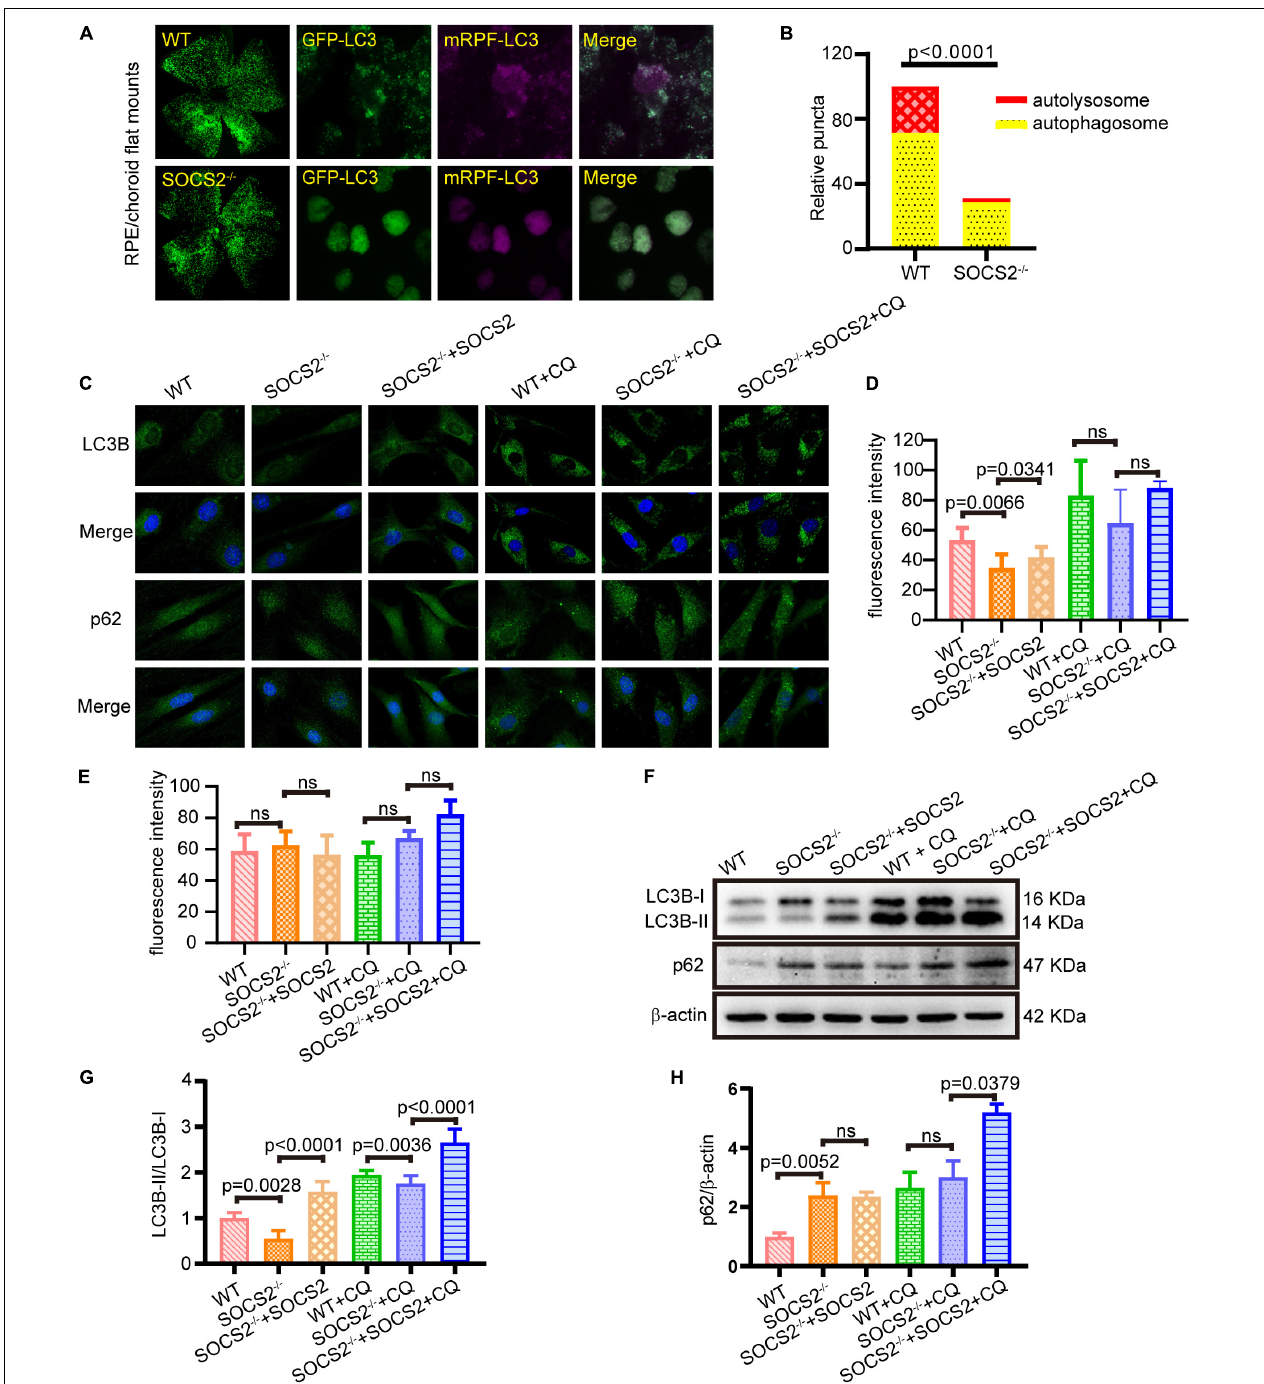
FIGURE 2 | RPE lacking the SOCS2 gene exhibited impaired autophagy. (A) In vivo , autophagic flux was detected by injecting 2 µ l of 1 × 10 12 vg/ml adeno-associated virus 2 (AAV2)-mRFP-GFP-LC3 in the eyeball of adult WT and SOCS2 − / − mice subretinally. About 2-weeks later, mice were starved for 24 h before euthanasia, and RPE/choroid flat mounts were isolated from mice ( n = 8, 10-week old, including males and females). (B) The numbers of autophagosomes and autolysosomes were evaluated by counting yellow and RFP dots. Puncta dots per horizon are shown as the mean ± SEM. (C) LC3B puncta dots (green) and p62 puncta dots (green) were stained by immunofluorescence in mouse primary RPE cells that were starved and treated with or without 30 µ M CQ for 24 h. One group of SOCS2 − / − RPE re-expressed SOCS2 by transient transfection. (D,E) Fluorescence intensity of LC3B and p62 were quantified by the ImageJ software. (F) Immunoblotting for LC3B and p62 was performed in mouse primary RPE with different treatments. (G) The ratio of LC3B-II/LC3B-I was quantified by ImageJ software and normalized to β -actin. (H) p62 was quantified by ImageJ software and normalized to β -actin. Values for the control were set to 1. Statistical significance was determined by using the two-tailed unpaired t